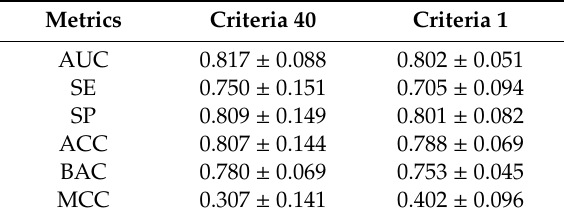
Table 2. Mean predictive performances for all assay